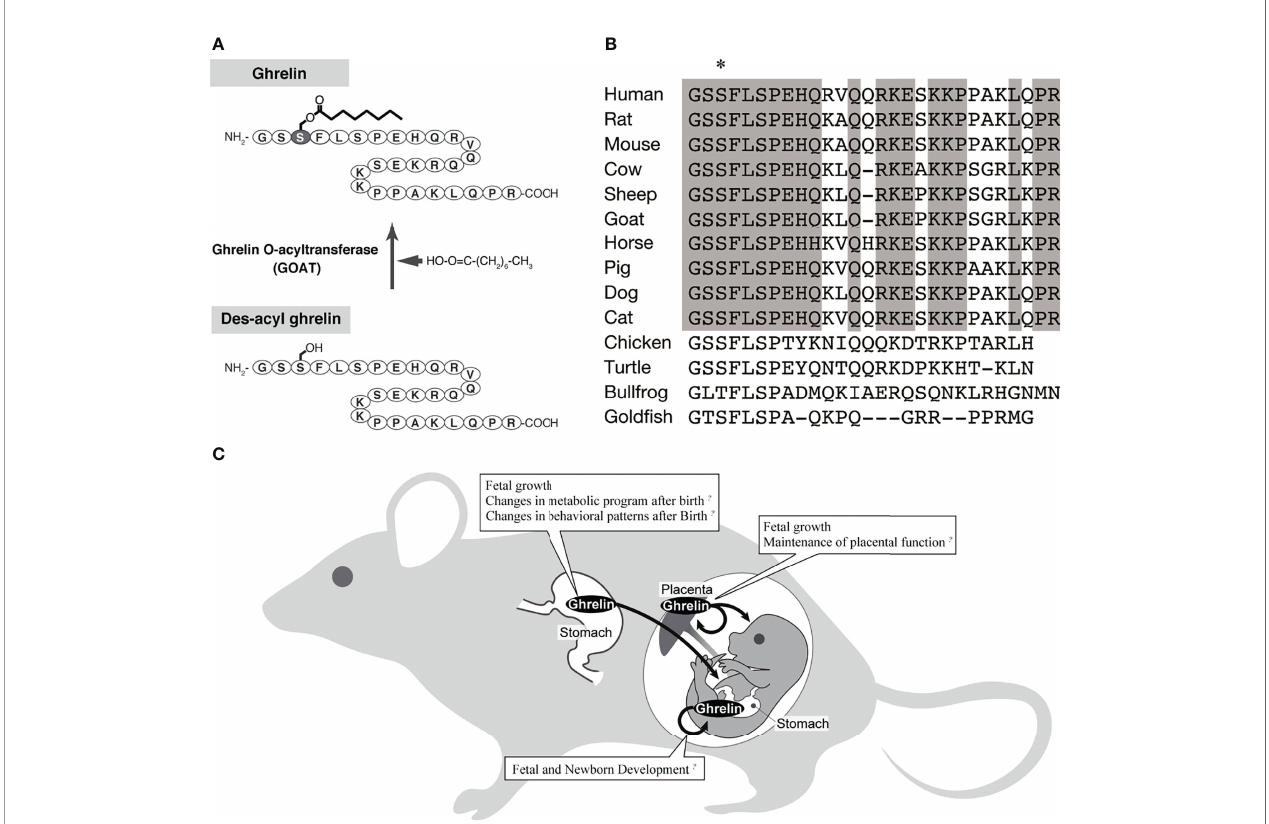
FIGURE 1 | The biochemistry of ghrelin and the action of ghrelin in the fetus. (A) Biosynthesis of ghrelin. The active form of ghrelin is produced by the action of a ghrelin-speci fi c fatty acid modifying enzyme (GOAT). (B) Comparison of ghrelin sequences, mainly from mammals (modi fi ed from Ida et al., 2010) (17). Asterisk indicates amino acid residues with fatty acid modi fi cations. Gray boxes indicate amino acids that are highly conserved among mammals. (C) A schematic diagram of the pathway of ghrelin from the mother to the